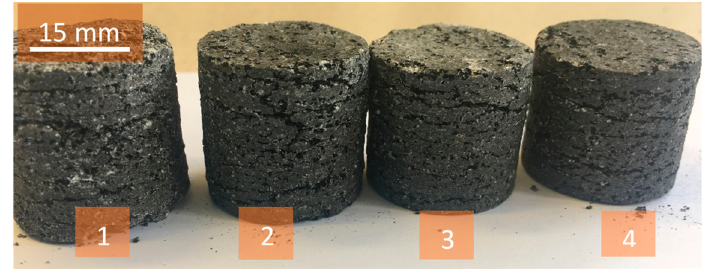
Figure 11. MSH / G + C pellet samples, No.1: MSH / G + C (0.4:1); No.2: MSH / G + C (0.6:1); No.3: MSH / G + C (0.8:1); No.4: MSH / G + C (1:1). All pellets were manufactured at a 5.2 kN · mm − 2 compression pressure.